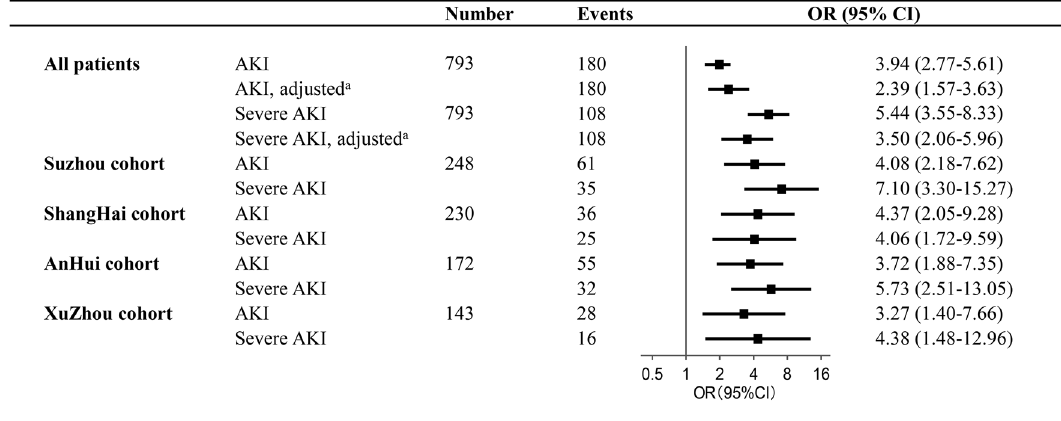
Fig. 2 The risk of AKI and severe AKI on the basis of urinary cystatin C. AKI, acute kidney injury; CI, confidence interval; OR, odds ratio. Urinary cystatin C as a dichotomous variable based on the cutoff of 1.26 mg/g urinary creatinine. AKI developed during the pediatric intensive care unit stay was defined by KDIGO criteria. Severe AKI was defined as KDIGO stage 2 or 3. a Adjusted for body weight, sex, illness severity assessed by the pediatric risk of mortality III score, sepsis, multi-organ dysfunction syndrome, shock/disseminated intravascular coagulation, and the use of mechanical ventilation, furosemide, and